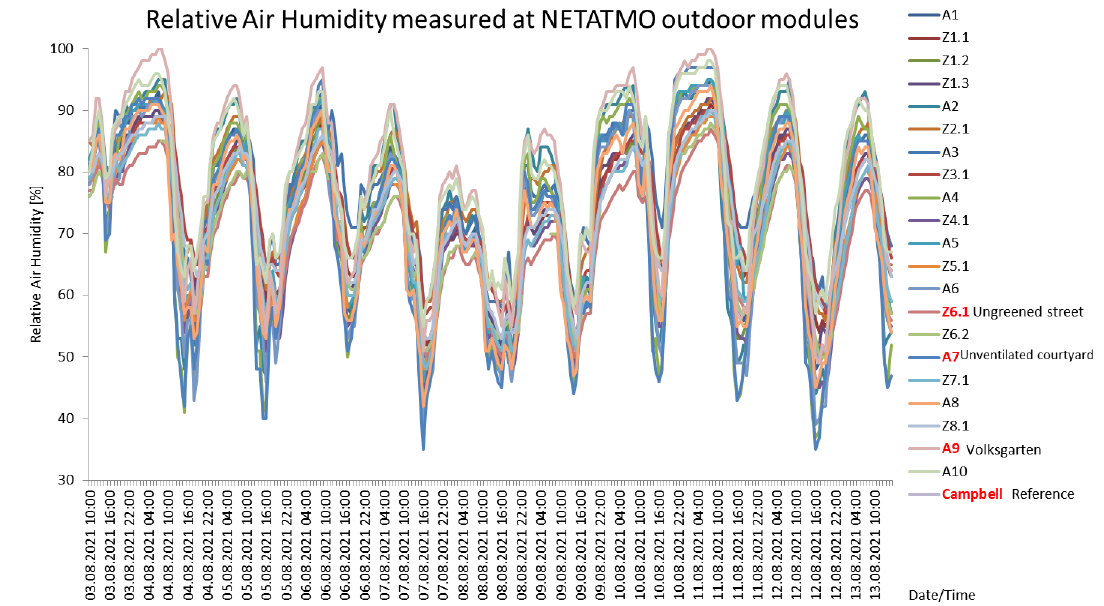
Figure 4. Relative air humidities measured at the NETATMO sensors in the study area during the eleven day test